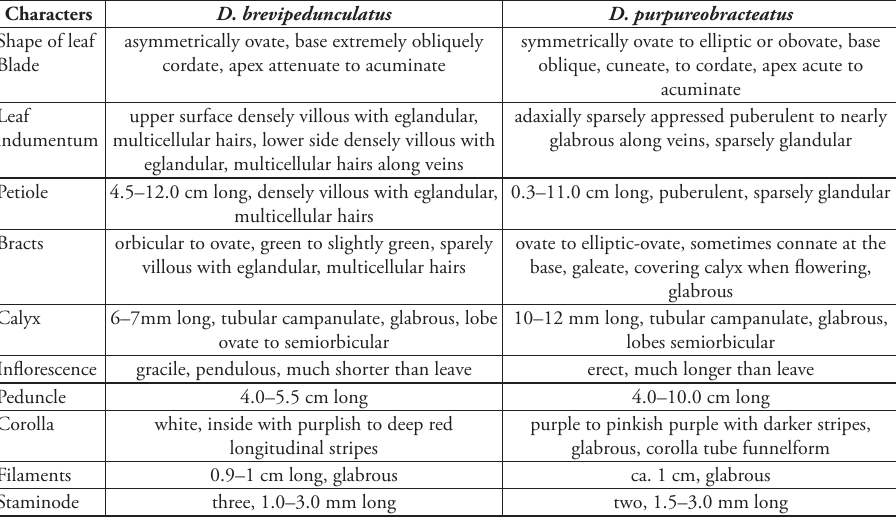
Table 3. Morphological comparison of Didymocarpus brevipedunculatus and its closely related species.